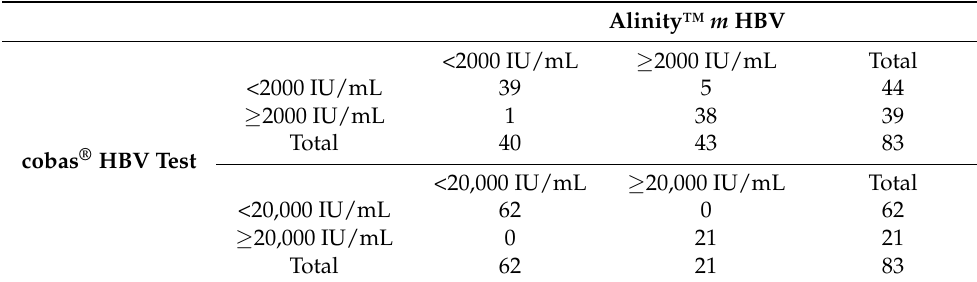
Table 2. Concordance at the 2000 and 20,000 UI/mL clinically relevant cutoffs between the cobas ® HBV test and Alinity™ m HBV